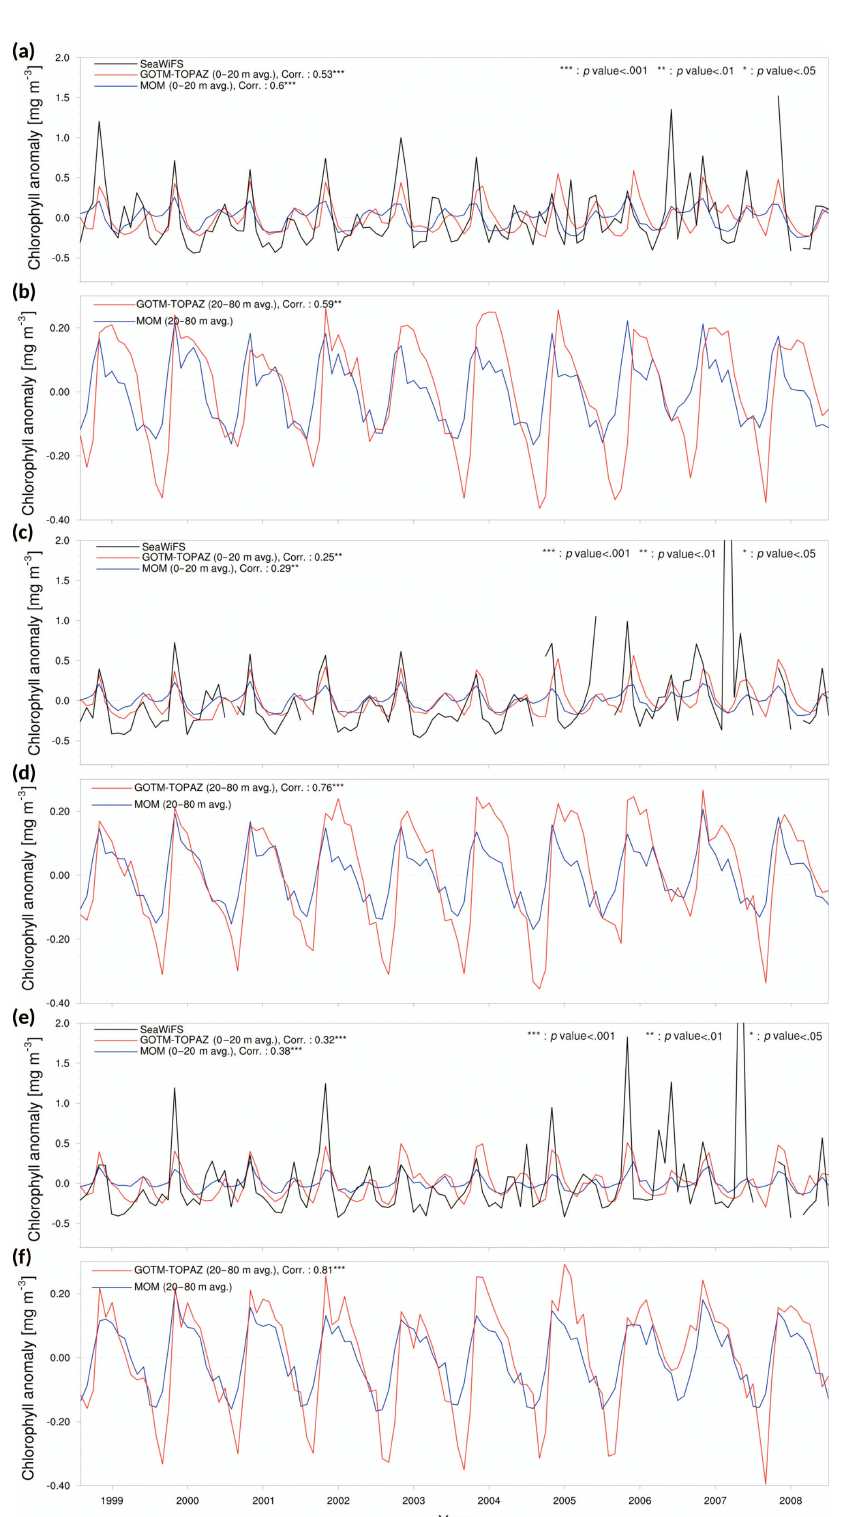
Figure 4. Chlorophyll anomaly time series and correlation values for observational data (black lines), MOM5_SIS_TOPAZ results (blue lines), and GOTM–TOPAZ results (red lines) for the 10-year period of 1999–2008. Panels (a) , (c) , and (e) show the mean values at depths ≥ 20m and the correlations between the observations and each model at points 107, 104, and 102, respectively. Panels (b) , (d) , and (f) show the mean values at depths of 20–80m and the correlation between the two models at points 107, 104, and 102,